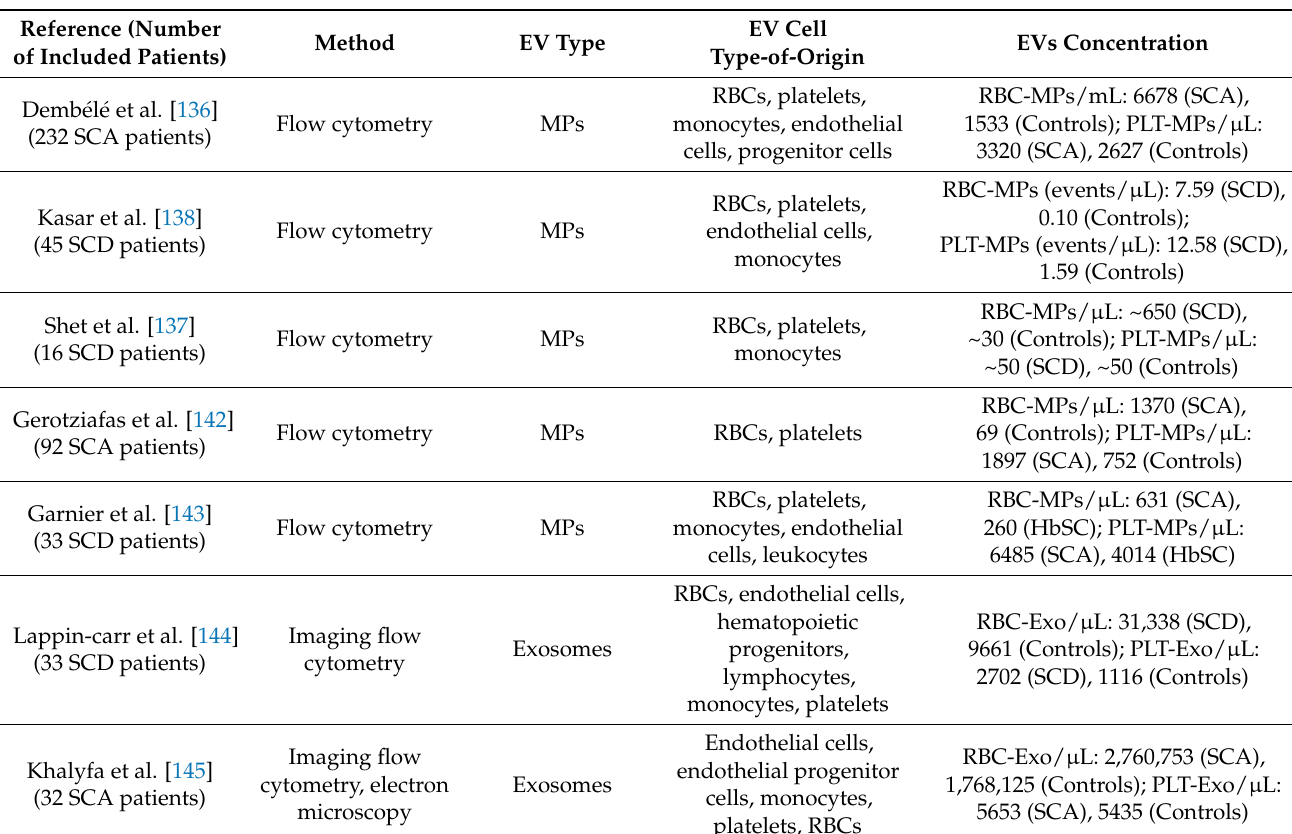
Table 2. Studies reporting increased EV levels in SCD. Markers proving an origin from RBCs, reticulocytes, platelets, monocytes, endothelial cells, leukocytes, or progenitor cells are